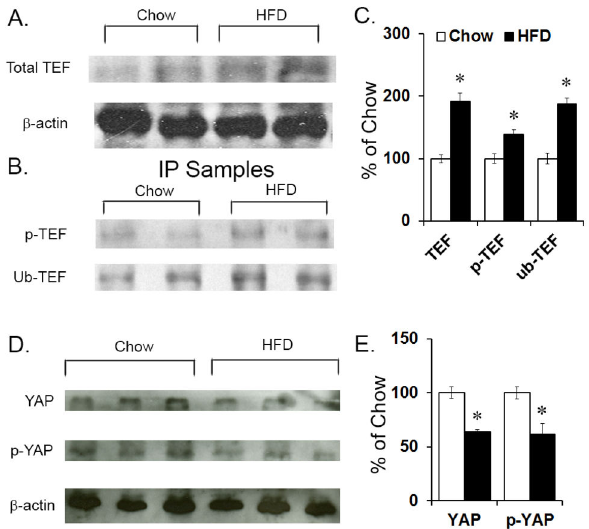
Figure 3. Protein levels in E19 embryos. (A, C) TEF protein level was measured via western blot in the PVN of high-fat diet (HFD) compared to chow E19 embryos, and a statistically significant increase was found for total TEF protein levels in whole hypothalamus. (B, C) Further immunoprecipitation (IP) of total TEF protein from whole hypothalamus revealed a statistically significant increase in levels of phosphorylated TEF and ubiquitin-tagged TEF. (D, E) YAP protein level was measured via western blot in whole hypothalamus of high-fat diet (HFD) compared to chow E19 embryos, and a statistically significant decrease in total YAP and phosphorylated YAP protein was found. Results are expressed as means ± SEM (n = 4). * p < 0.05. The β-actin bands were used to ensure that all samples had the same concentration of protein; they were not used to normalize TEF and YAP bands. The change in TEF and YAP band densities from the HFD group was determined relative to the chow control